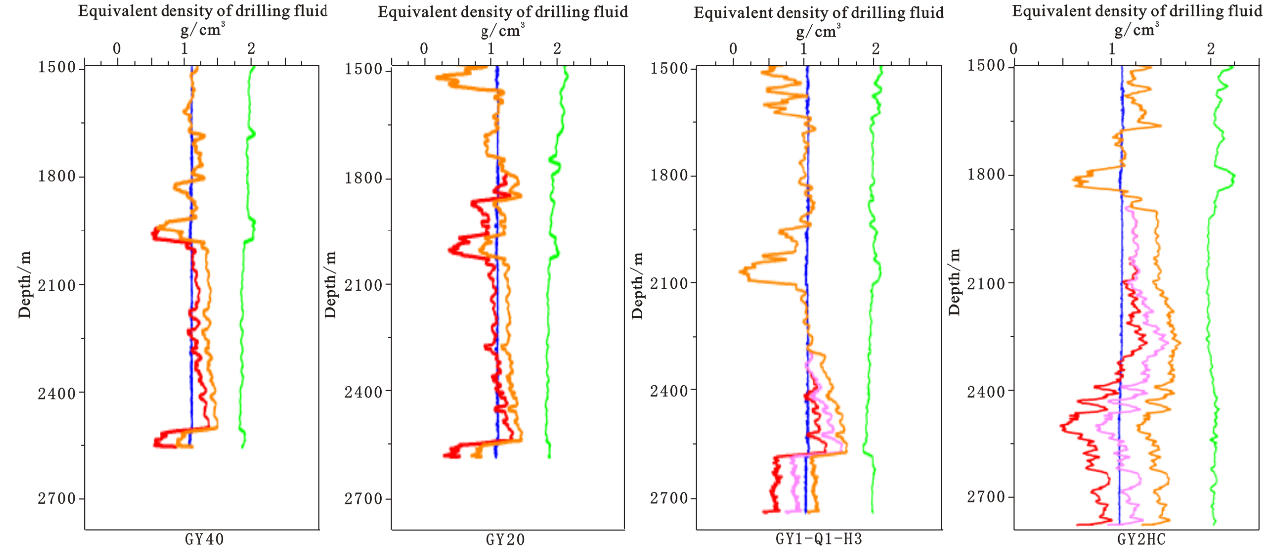
Figure 4. Prediction of safe density window of drilling fluid.